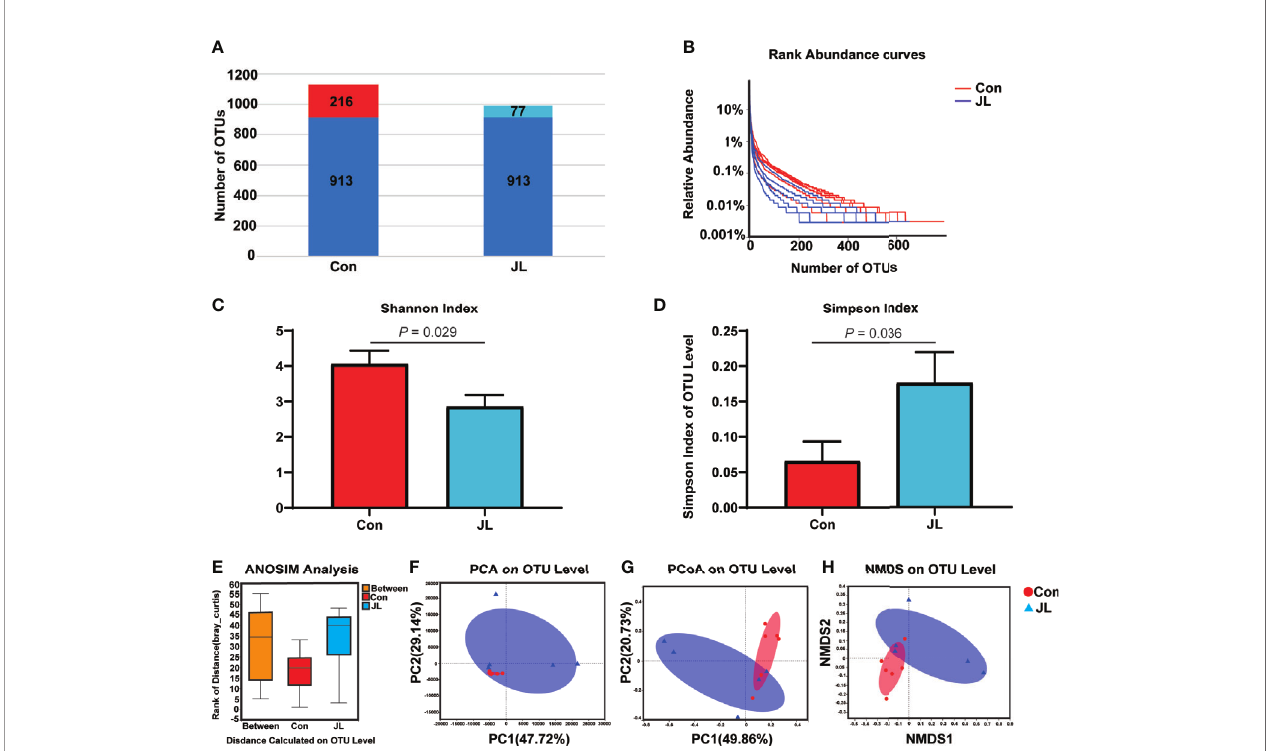
FIGURE 4 | Comparison of bacterial components, abundance, a -diversity (Shannon index and Simpson index), ANOSIM analysis, and b -diversity (PCA, PCoA, and NMDS) based on OTU level in jejunal microbiota of normal rhythm mice (Con; n = 6) and jet-lagged mice (JL; n = 5). (A) Histogram shows the number of OTUs in the Con and JL group. (B) Rank-abundance curves. (C) Shannon index and (D) Simpson index of Con and JL groups. (E) ANOSIM analysis between two groups. (F) PCA, (G) PCoA, and (H) NMDS analysis of jejunal microbiota. Values are presented as the means ± SEM. a -diversity was assessed by student ’ s t test and b -diversity was assessed by ANOSIM